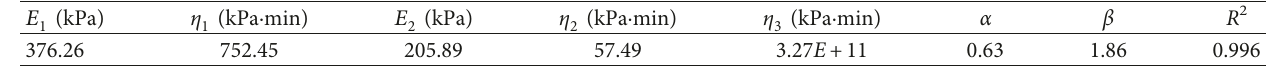
Table 6: Improved Burgers damage creep model parameters of artificially frozen soil [35]. E 1 (kPa)